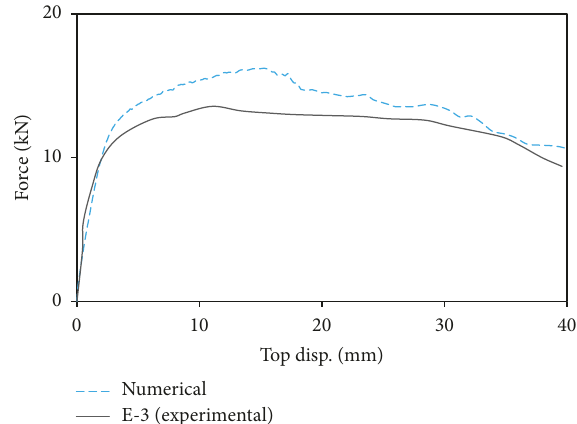
Figure 8: Comparison of force-displacement curves of the numerical and the experimental results under out-of-plane loading in Varela- Rivera et al. [17].